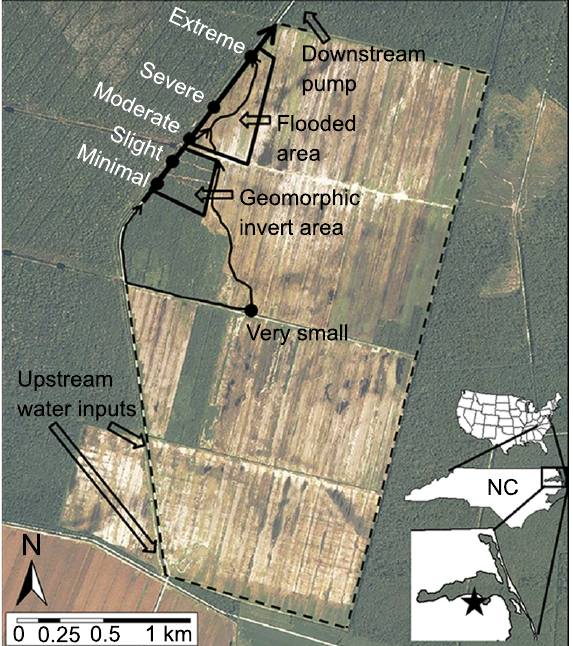
Fig. 1. Timberlake mitigation site (outlined in dashed line) in the Albermarle Sound region of North Carolina. The six sampling sites (circles) are named according to strength of the dewatering effect. Trapezoids designate approximate regions of the flooded area pre- and post-dewatering and the geomorphic invert that minimized the dewatering effect on more upstream sites. The solid, bold arrow outlines the path of the main gradient used in this study; smaller arrows indicate alternate water flow